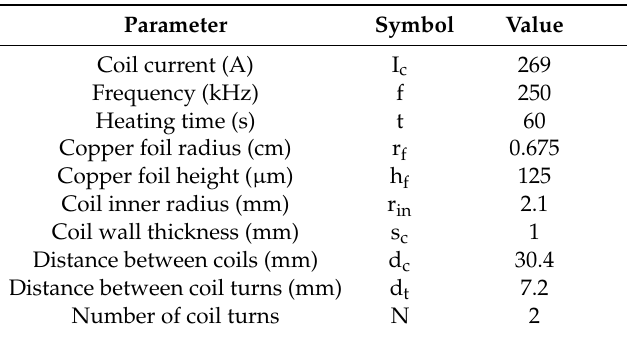
Figure 6. Flowchart of solving strategy of the coupled electromagnetic Maxwell’s equations and thermal equation in transient. The heat is generated by eddy currents, which flow through copper foil and create a Joule heat I 2 R. Table 2. Simulation parameters.